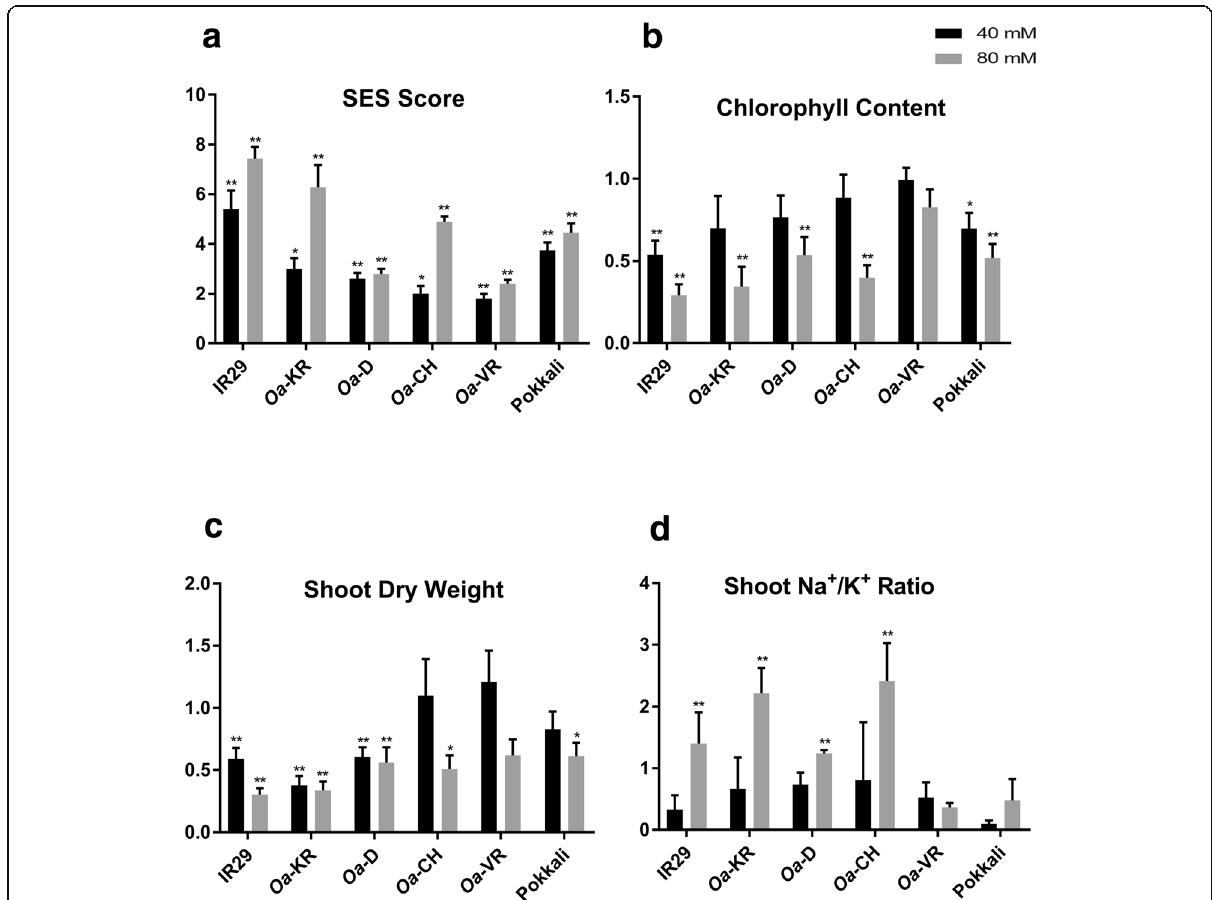
Pokkali (salt tolerant). Trait means (± standard errors) are shown for each genotype under 40 and 80 mM NaCl (EC = 8.7 dS m -1 ) at the